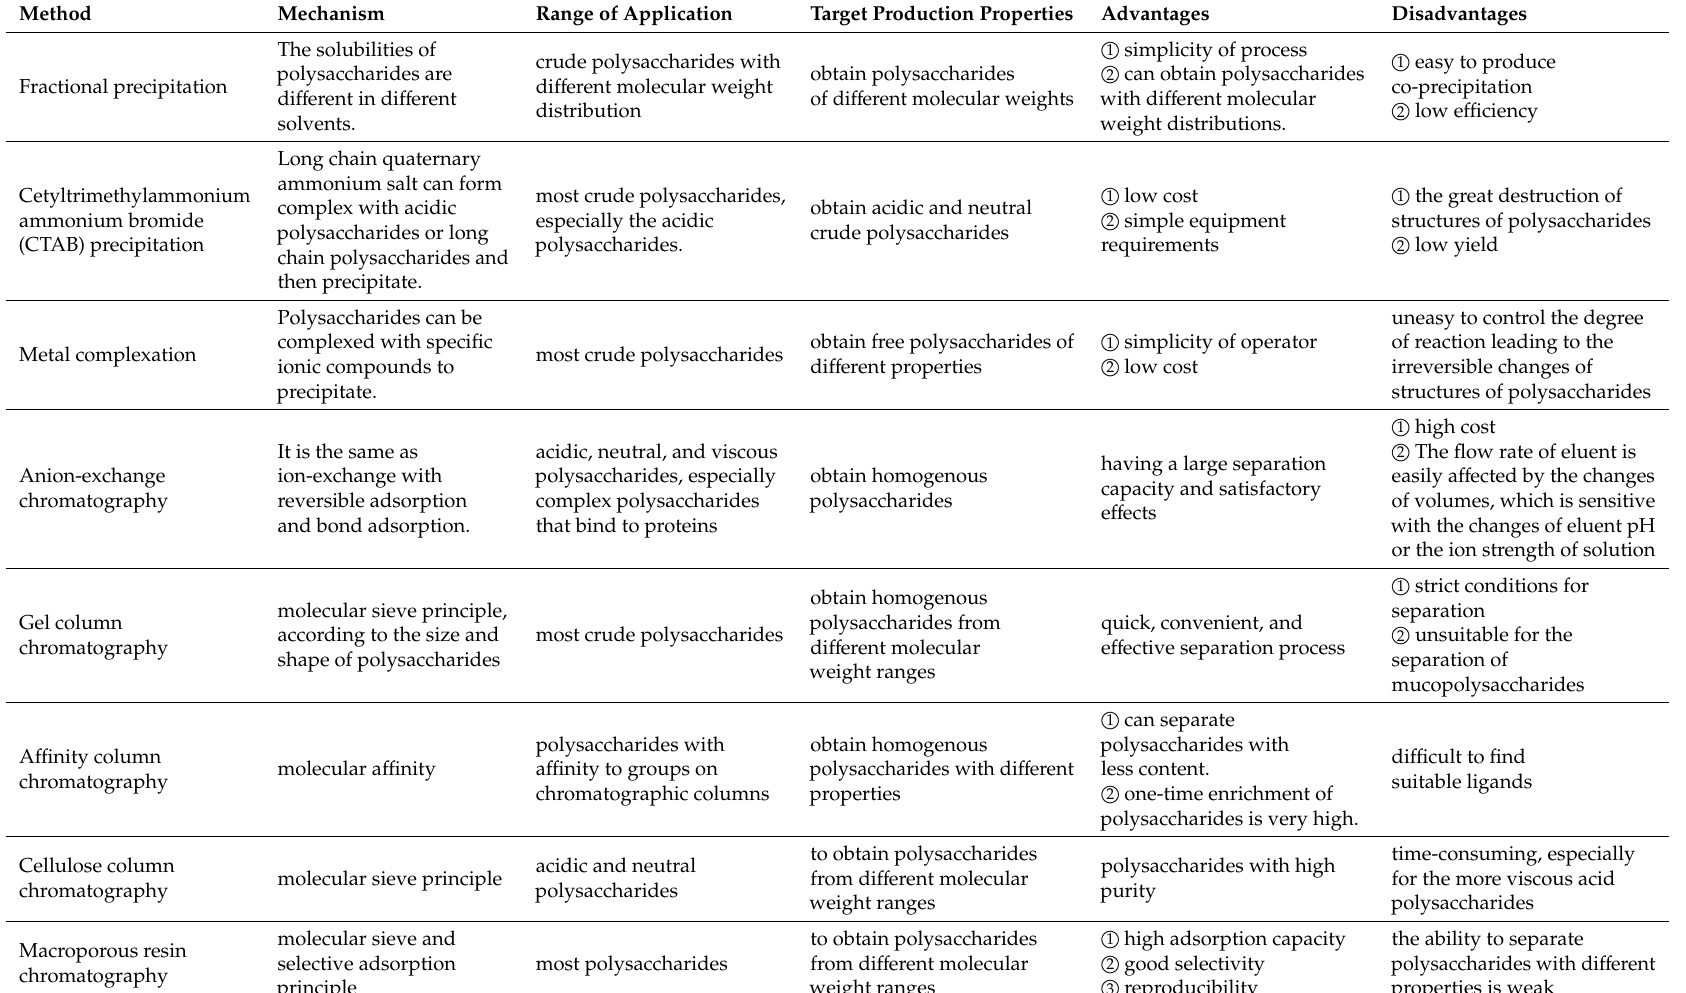
Table 1. Summary of methods of purification of polysaccharides from natural